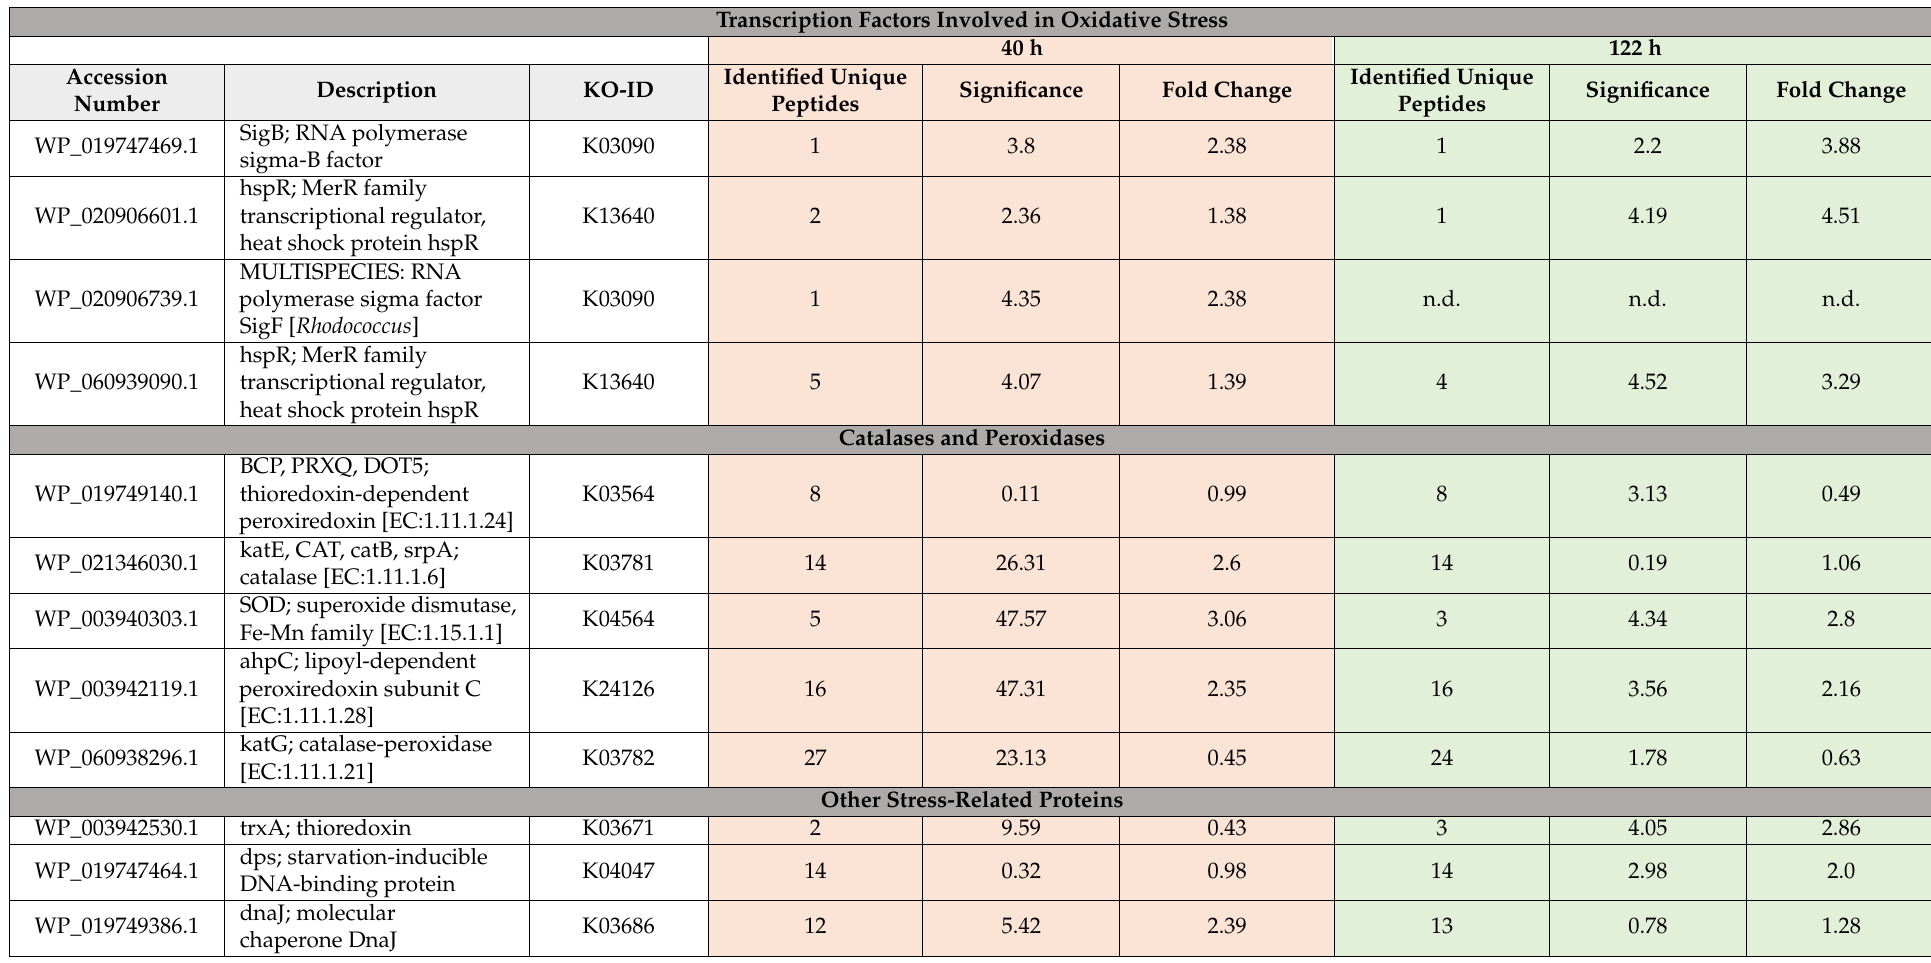
Table 1. Selected proteins involved in oxidative stress discussed here. Protein abundance and fold change in samples grown under white light were compared to non-illuminated control. NCBI accession numbers as well as matched KO identifiers are listed. Further identified unique peptides, significance and fold change at 40 h and 122 h of samples are stated. Fractions below 1 depict downregulation. n.d. = not